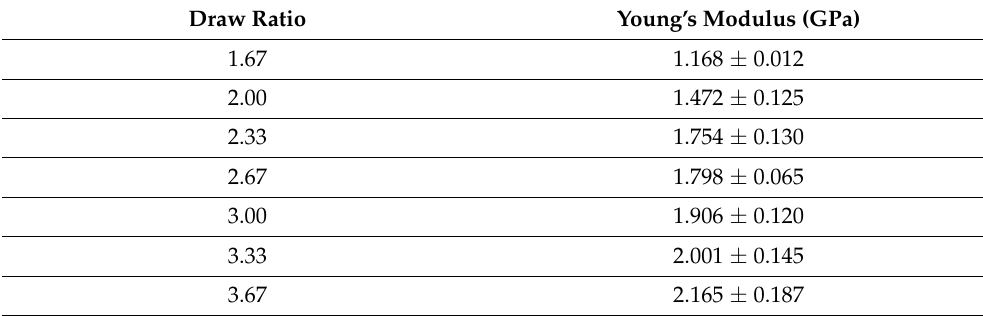
Figure 5. Elongation at Break and Tensile Strength of Bicomponent Fibers as a function of Draw Ratio. Table 3. Draw Ratio vs. Young’s Table 3. Draw Ratio vs. Young’s Modulus.